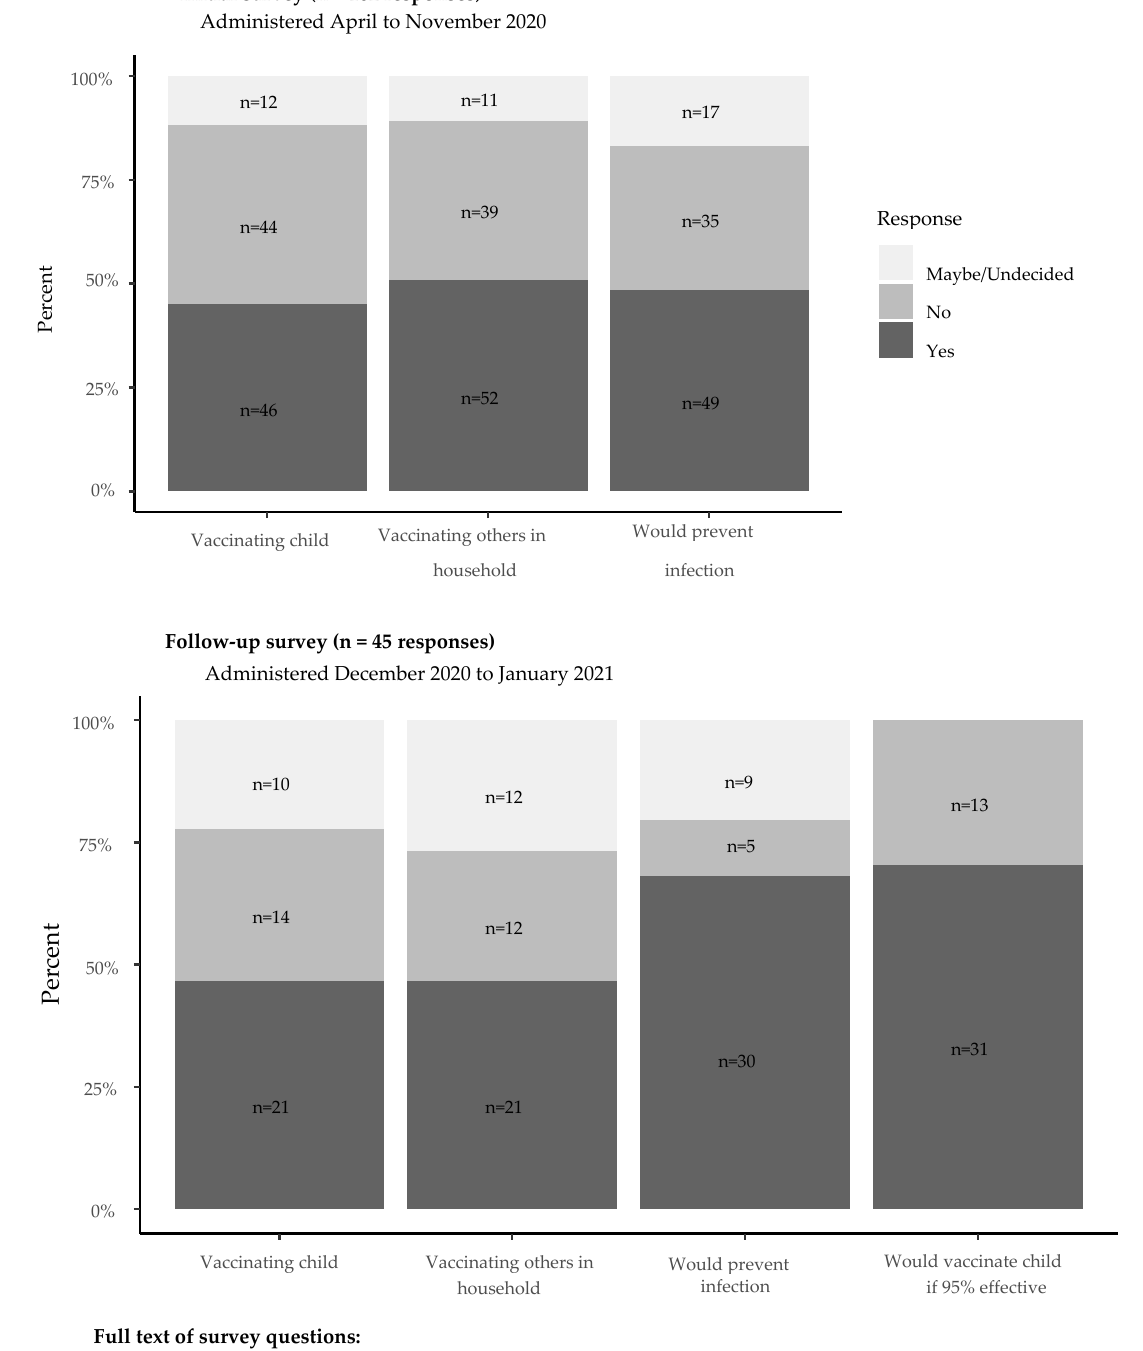
Figure 1. Guardian vaccine acceptability on first and second surveys